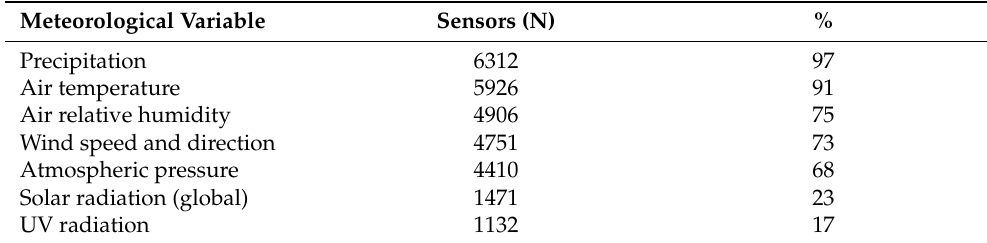
Table 3. Number of sensors installed inside the MNW network. The percentage column is calculated in regard to the total number of operative weather stations